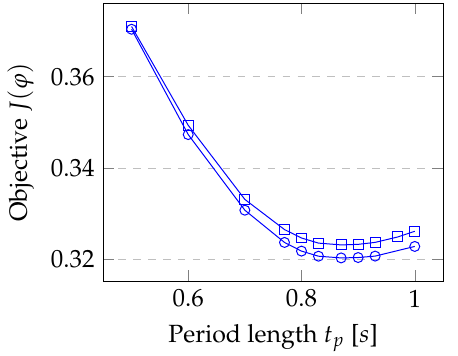
Figure 3. Selection of resolution. Segregation intensity for ∆ x = 36.9 µ m ( ) and ∆ x = 27.7 µ m ( ) and varying period length t p , with a = 1.2, d = 0.5 and acoustic scaling ( ∆ t ∼ ∆ x ). Although the values depend on the resolution, trend and location of the minimizer are identical for both